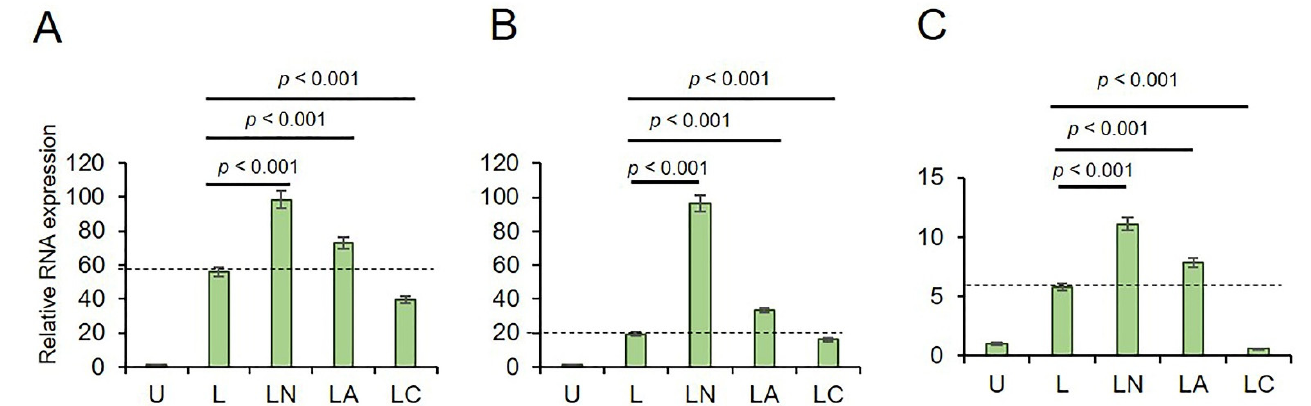
Figure 2. The effect of LPS-Az and LPS-Cf on RNA levels of NLRP3 associated genes in A549 cells. ( A ) NLRP3, ( B ) Pro-CASP1, ( C ) Pro-IL-1 β . U: Untreated, L: LPS, LN: LPS-Ng, LA: LPS-Az, LC: LPS-Cf. p values were calculated using one-way ANOVA and Tukey's post-hoc tests (n = 3). Dotted line indicates RNA expression in LPS primed A549 cells. Data is presented as Mean ± SD.